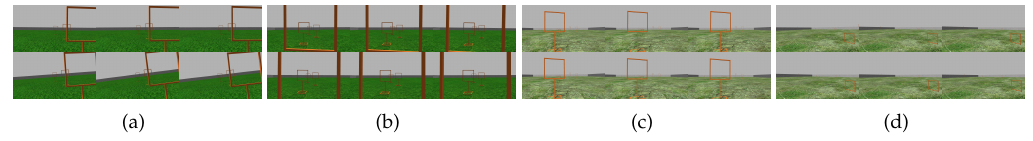
Figure 12. Mosaic image examples where each mosaic image ( a – d ) is composed of 6 frames.